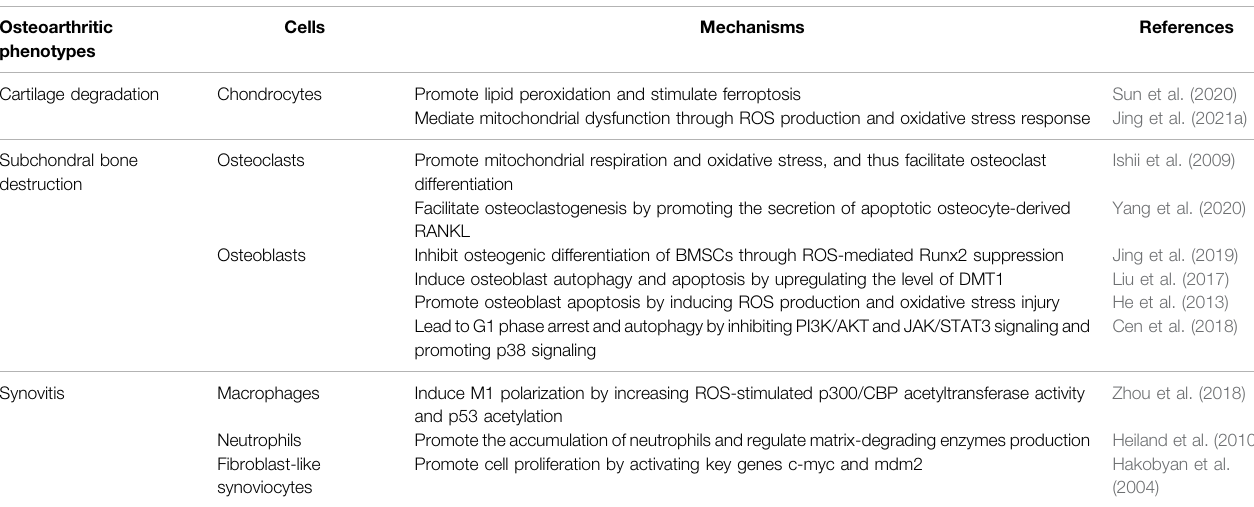
TABLE 1 | Cellular and molecular mechanisms underlying the interplay between iron overload and